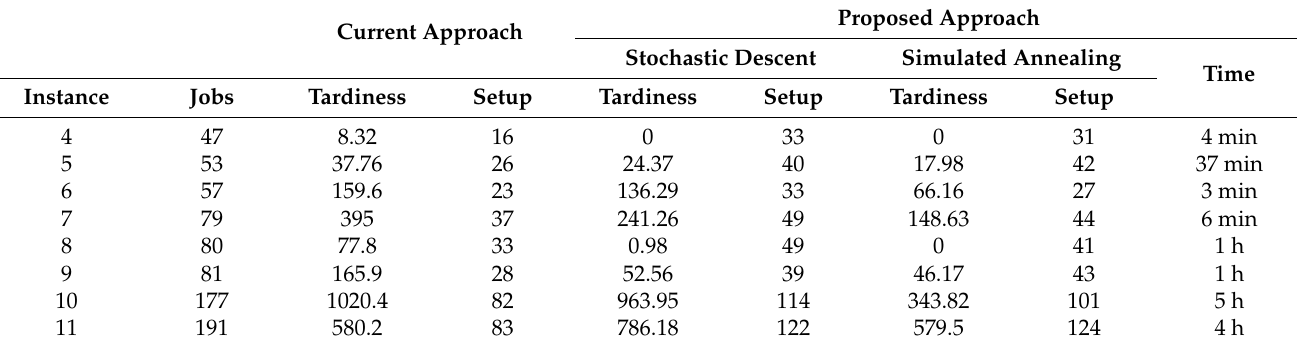
Table 4. Comparison of results between the benchmark method and the proposed